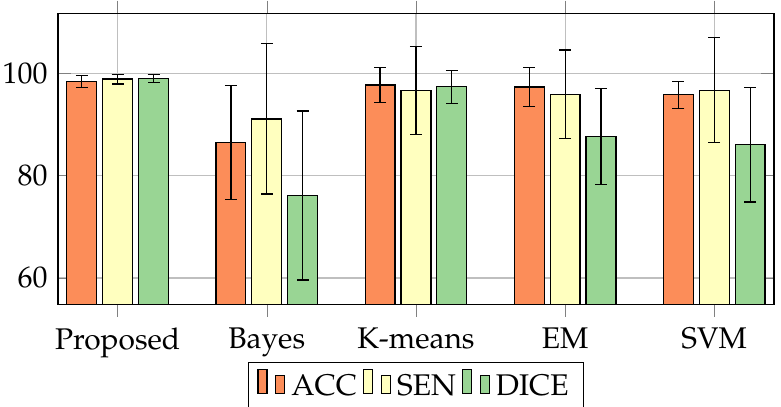
Figure 9. Illustration between metric values obtained, comparing the Proposed Method to other methods in the literature based on transfer learning presented by Table 7, with the combined models; Mask + Bayes, Mask + Kmeans, Mask + EM and Mask + SVM from the study of [13].